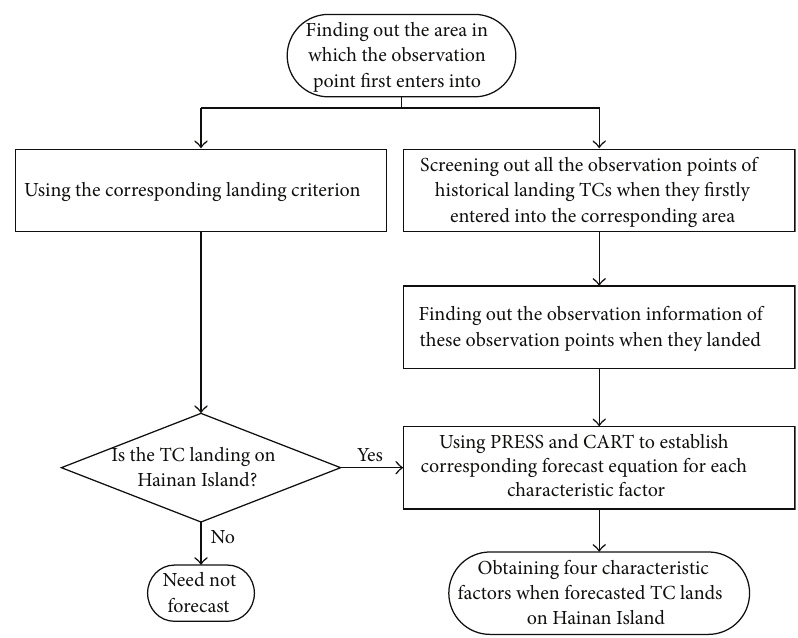
Figure 7: Flow diagram of landing prediction pattern.